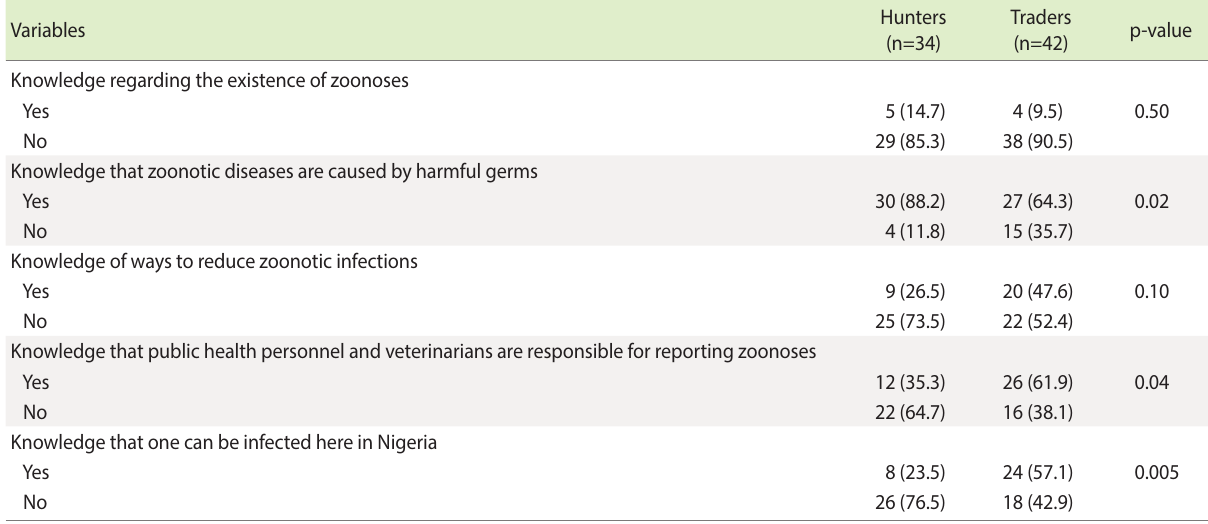
Table 2. Respondents’ knowledge of zoonotic diseases